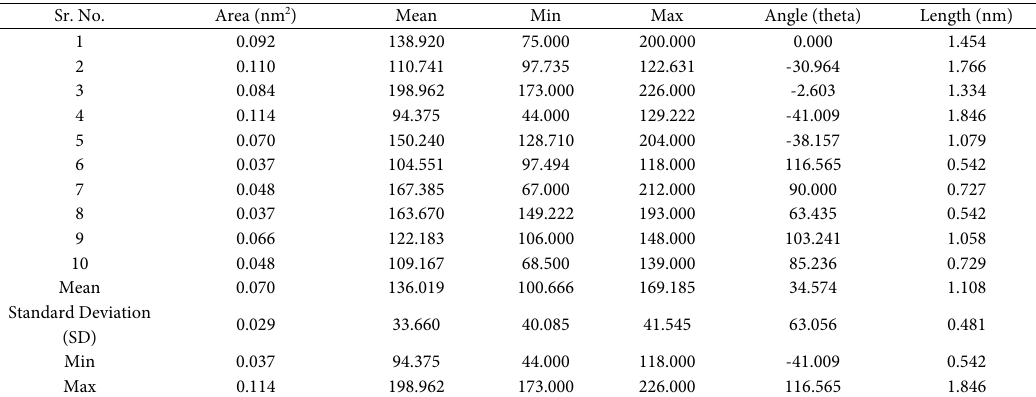
Table 6. FESEM Parameters of